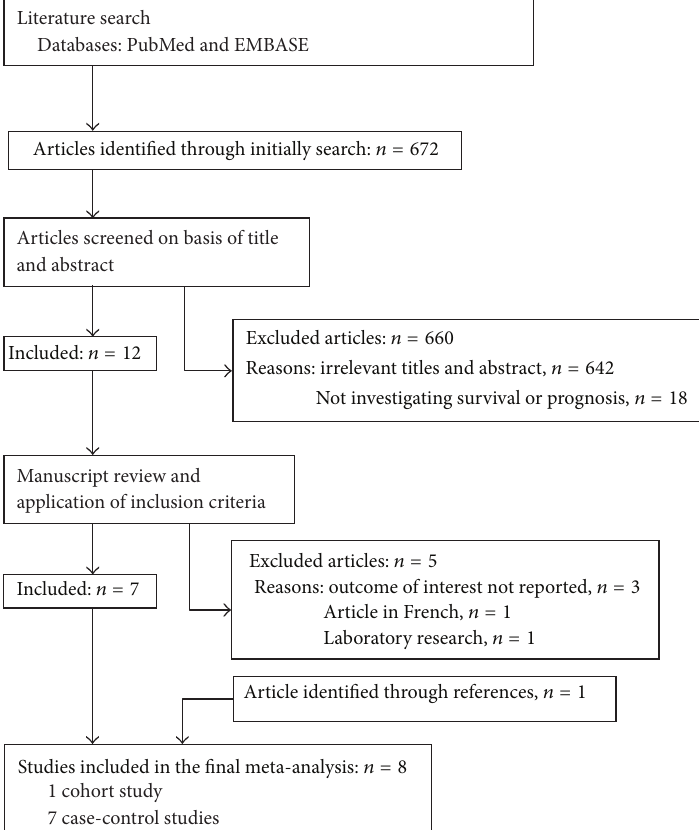
Figure 1: Flow chart of literature search for this meta-analysis.